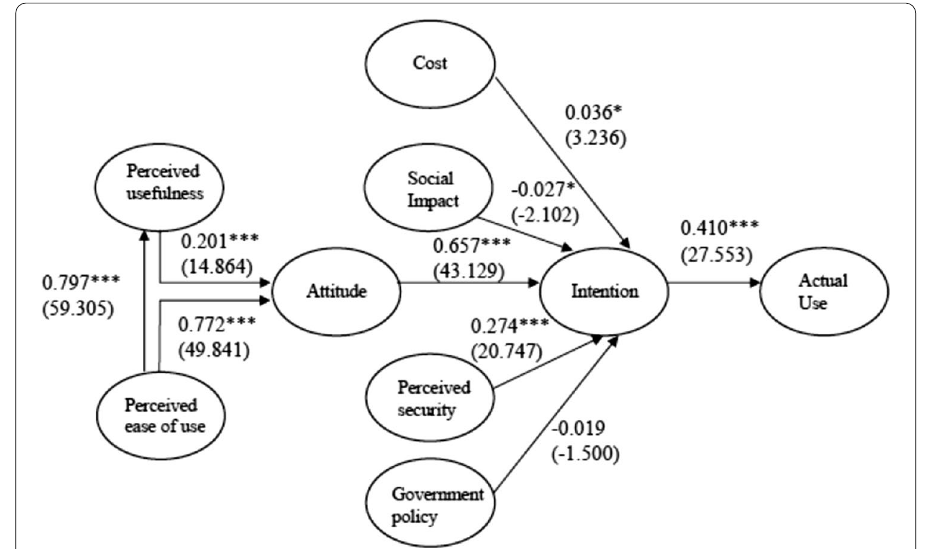
Fig. 2 Result of the research